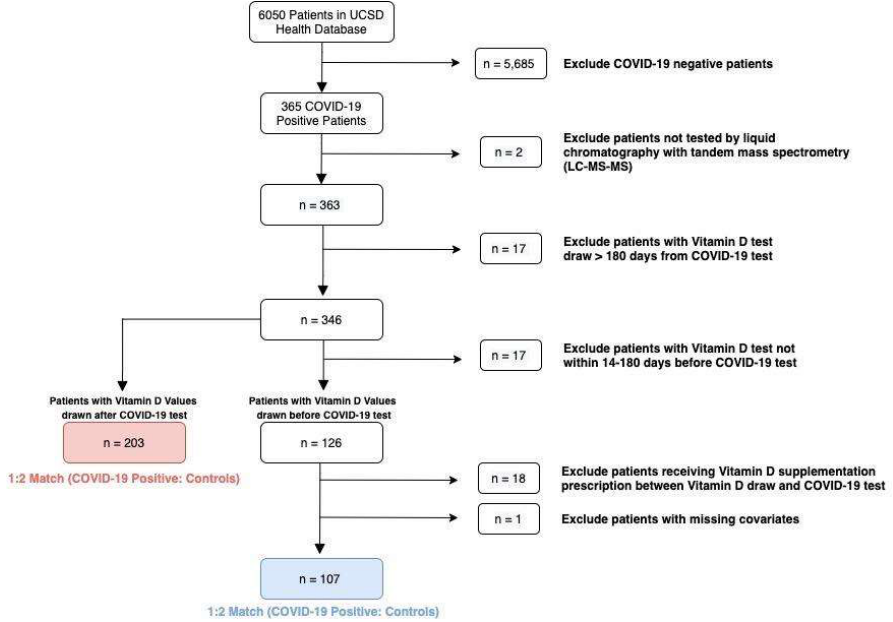
Figure 1. Flow diagram showing the selection of study subjects and controls.